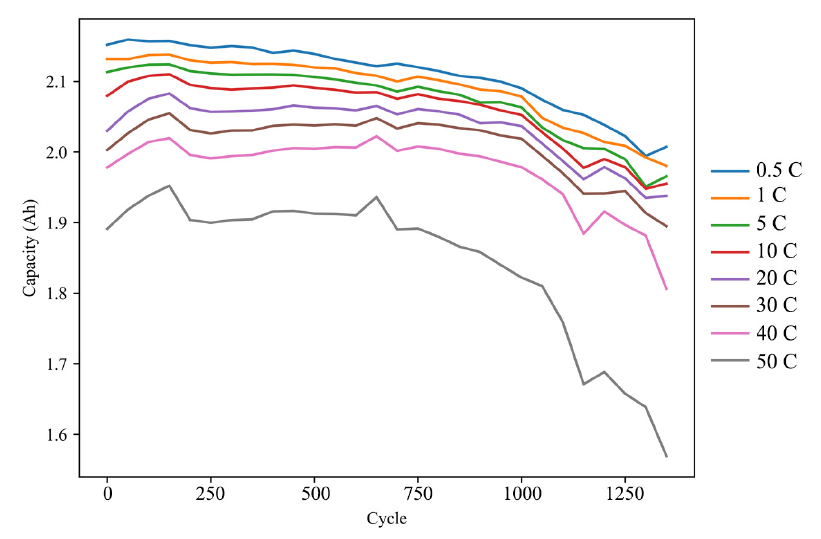
Figure 2. The capacity at all current rate of cell #7 during aging cycles.